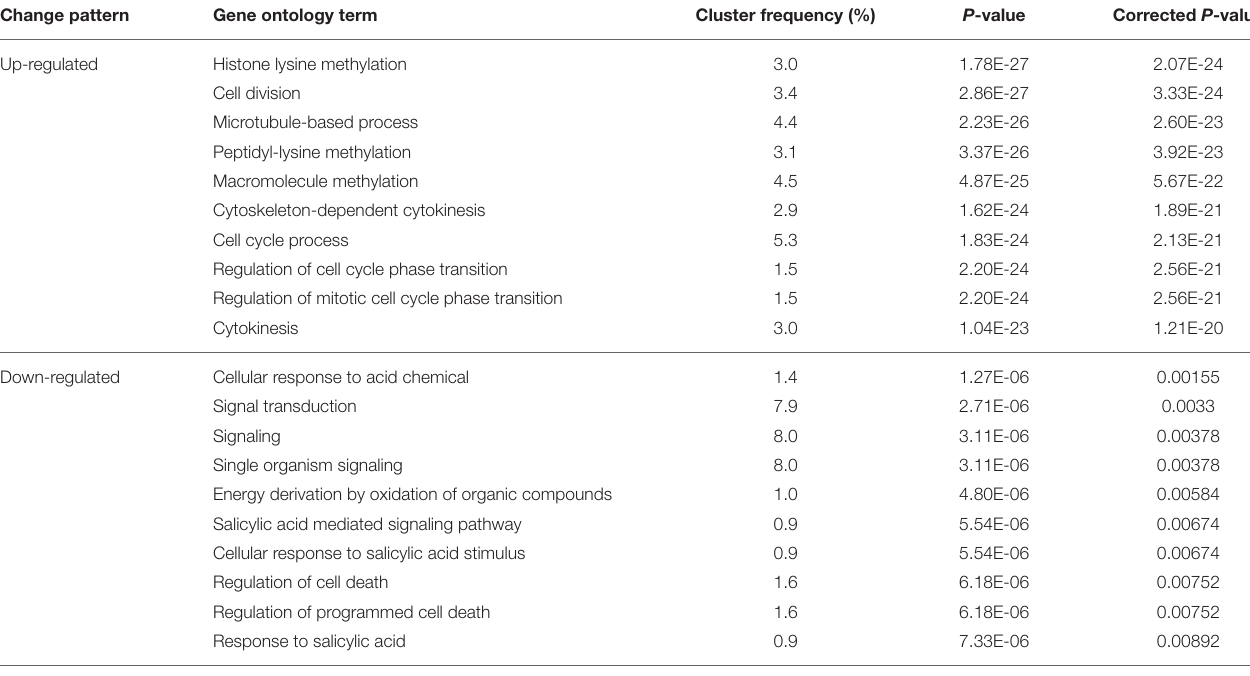
Top 10 most significant processes are displayed. TABLE 4 | Changes in biological processes in buds indentified by GO analysis during Stage II to Stage III transition. Change pattern